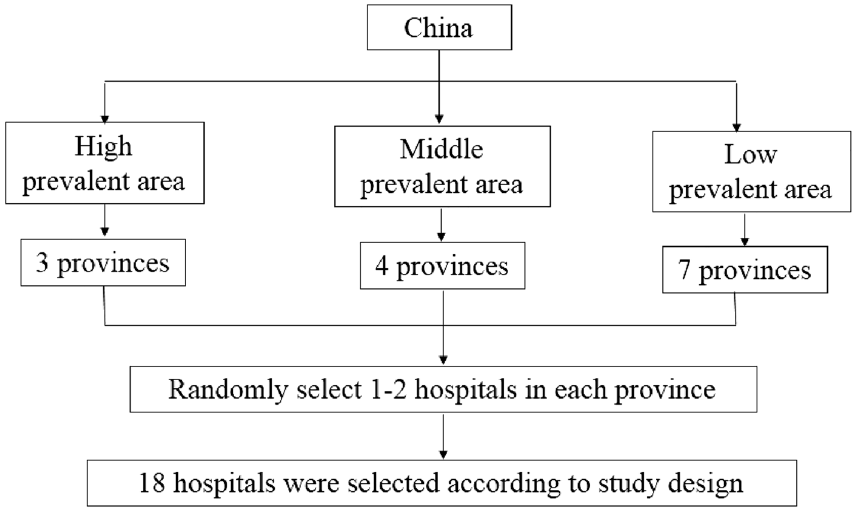
Figure 1. Flow chart of the survey sampling